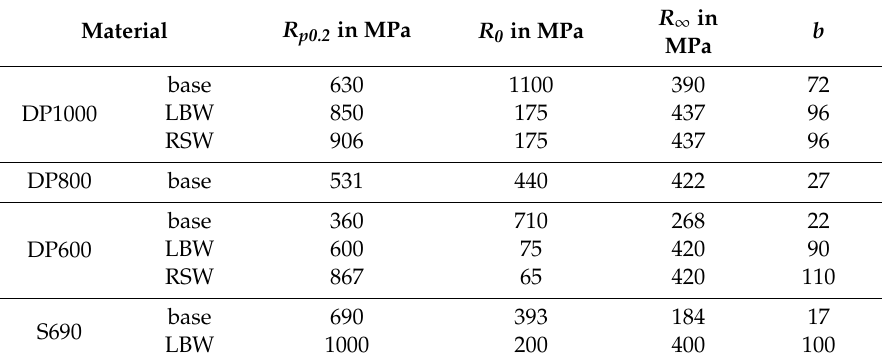
Table 4. Material model parameter sets for the validation of the ANN [45].